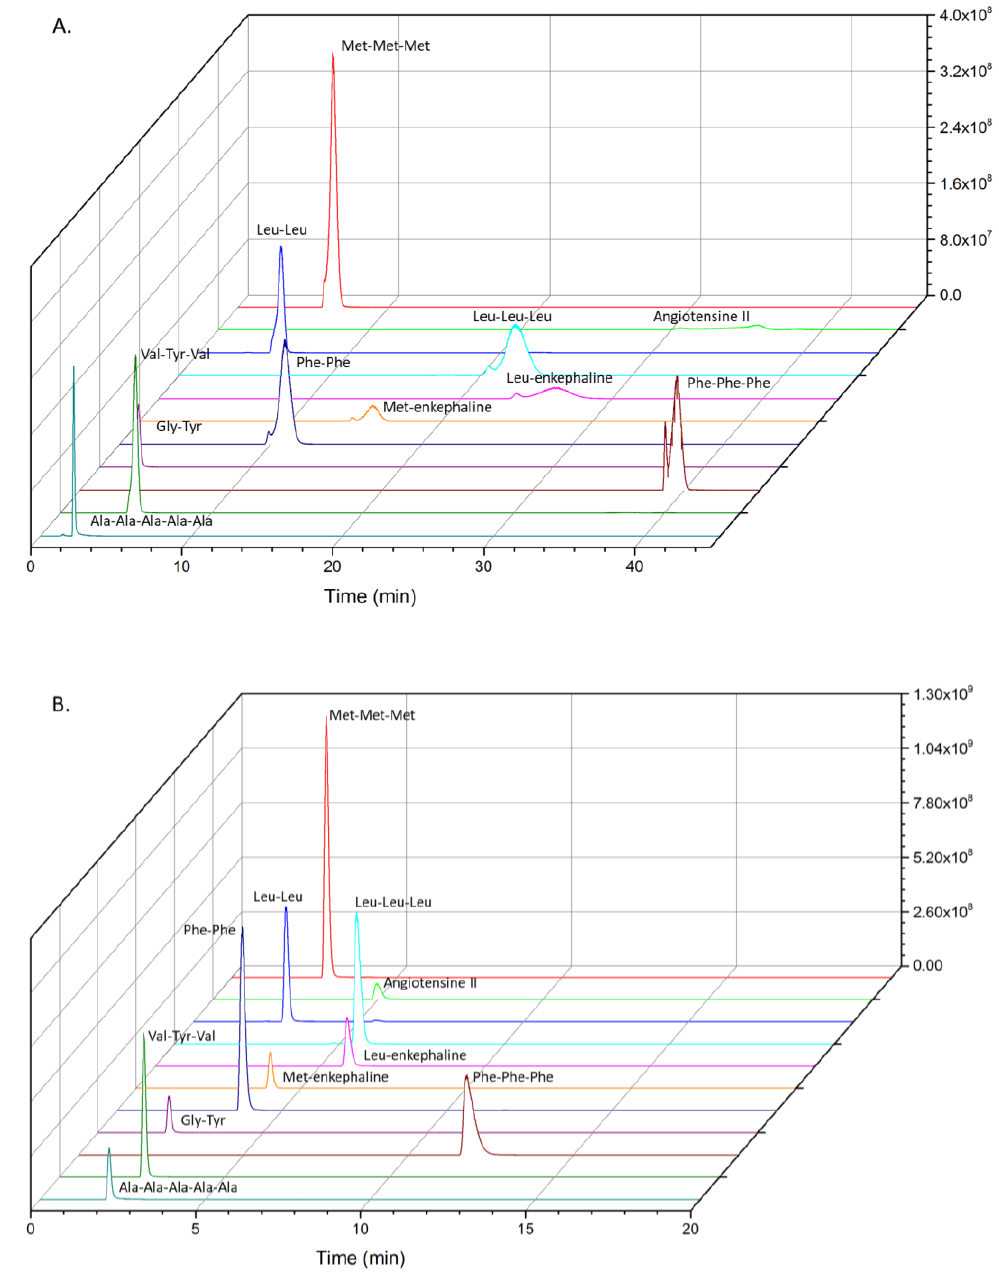
Figure 3. Extracted ion chromatogram of trapped peptides (0.5 µ g/mL) on Hypersil Gold aQ (50 mm × 1 mm, 40 ◦ C). Backflush-elution with ( A ) 10 % ACN and ( B ) 20%